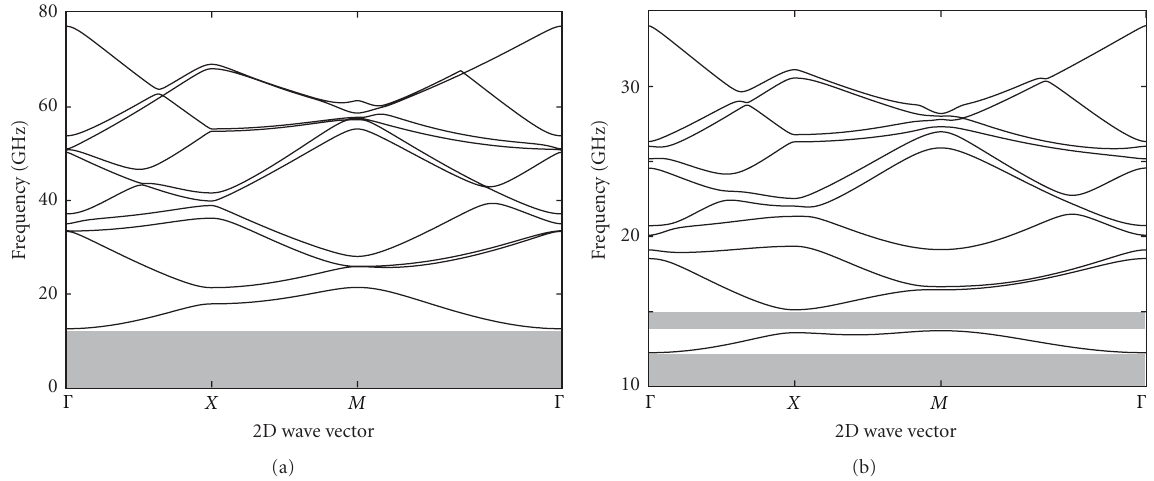
Figure 2: Ten lowest bands in the spin-wave spectrum of a 2D Co/Fe composite with lattice constant (a) 50 nm and (b) 100 nm, calculated along the high-symmetry line in the 2D Brillouin zone (cf. Figure 1(b)). Circular cross section of the rods ( RR = 1) and filling fraction f f = 0 . 5 are assumed in both cases. Shaded areas represent magnonic gaps. Note the plots di ff er in frequency range: 0GHz to 80 GHz in (a), and 10GHz to 35GHz in